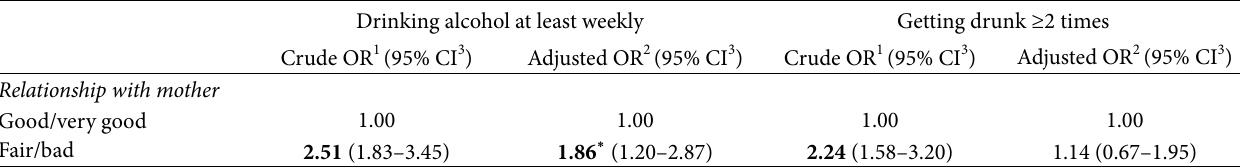
Table 3: Comorbidity of frequent alcohol drinking and getting drunk with depression, anxiety disorders and other substances use in 16–18 years-old adolescents in Greece ( 𝑁 = 2431 ).